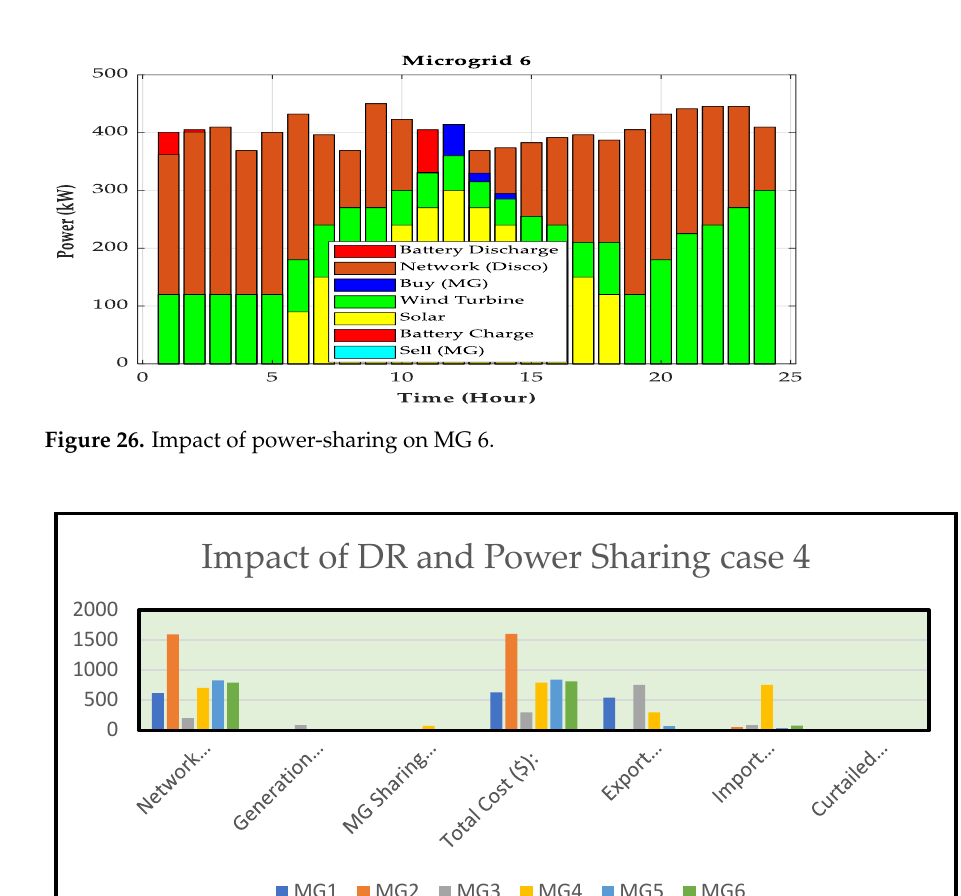
Figure 27. Case 4 ’s impact on the cost and losses. Figure 27. Case 4’s impact on the cost and